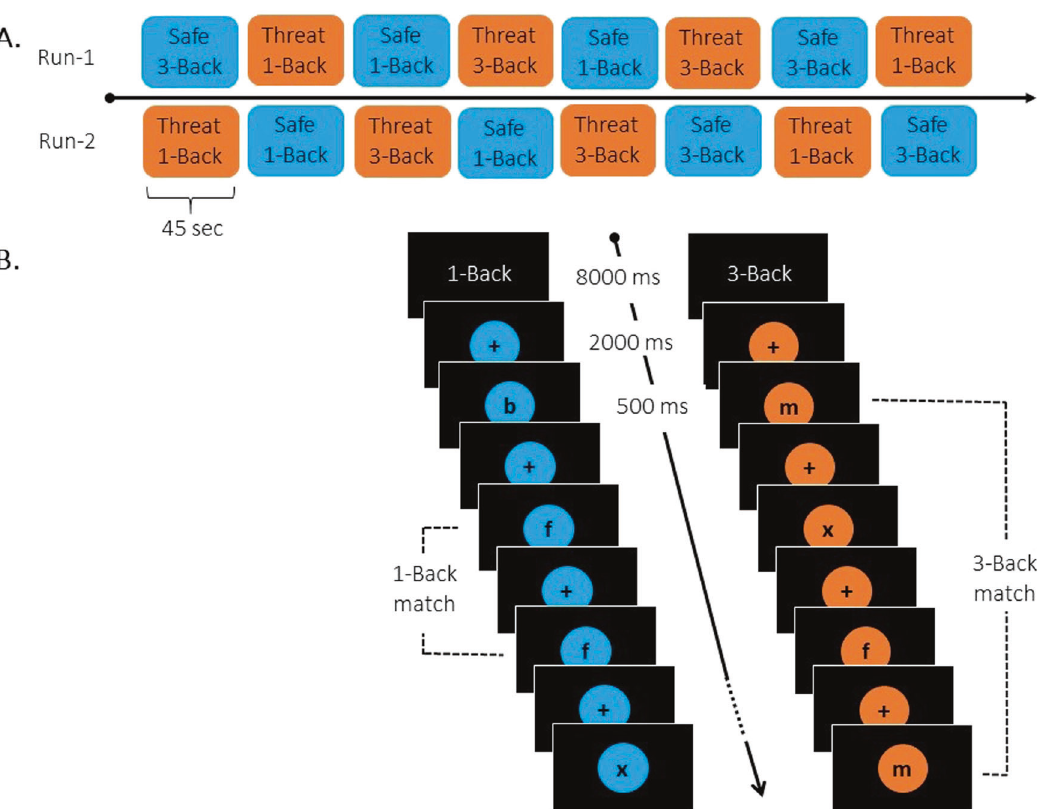
Fig. 2 Schematic of the N -Back working memory (WM) task. A Illustration of the two runs, one starting with a Threat block, and the other with a Safe block. The order of runs was counterbalanced across participants. In addition, participants performed the task in two different contexts, safety (Safe blocks) or threat of electrical shock (Threat blocks). Safe and Threat blocks alternated within each run and were paired with dif fi culty (i.e., 1-Back or 3-Back task). Each run comprised 8 blocks (45 s each) in total, with 2 blocks per task condition (i.e., 1-Back/Safe, 1-Back/Threat, 3-Back/Safe, 3-Back/Threat). B Illustration of a Safe block (letters surrounded by blue color) of a 1-Back task and a Threat block (letters surrounded by orange color) of a 3-Back task. At the beginning of each block, an instruction screen (8000 ms) noti fi ed participants of task load, i.e., 1-Back or 3-Back task. Within each block, 18 letters were sequentially presented for 500 ms at 2000 ms interval. Prior to the experiment, participants were instructed that, during the Safe blocks (letters surrounded by blue color), they would never receive an electrical shock, whereas unpredictable electrical shocks could be delivered at any time during the Threat blocks (letters surrounded by orange color). In total, six shocks were delivered throughout the task, three in each unpredictable electrical shocks (Threat blocks) (see Fig. 3A). Each Safe and Threat block was paired with a level of dif fi culty (1-Back, 3-Back), so that each run contained two blocks per conditions (i.e., 1-Back/Safe, 3-Back/Safe, 1- Back/Threat, 3-Back/Threat). The color surrounding the letter presented on the screen signaled a Safe block (blue) or a Threat block (orange). Participants were instructed that they would never receive an electrical shock during the Safe blocks (blue) but that they could receive unpredictable electrical shocks at any time during the Threat blocks (orange). In total, six shocks were delivered throughout the task, three per run (see Supplemental Material for additional details related to shock intensity calibration). Anxiety subjective ratings Subjective anxiety was assessed from two perspectives, general anxiety state across the whole study visit and anxiety in the fMRI, speci fi cally linked to task performance. The State-Trait Anxiety Inventory [STAI-s; [35]] monitored general state anxiety at three time points: (1) STAI-s 1, right after drug administration (T1), when the pharmacological action of the drug had not yet started to take effect, (2) STAI-s 2, 45 min post drug administration. At this time, MPH was expected to start having clinical effects (T2). Finally, (3) STAI-s 3, as soon as participants were removed from the scanner (T3). Information related to anxiety assessment during fMRI are presented in Supplemental Material.